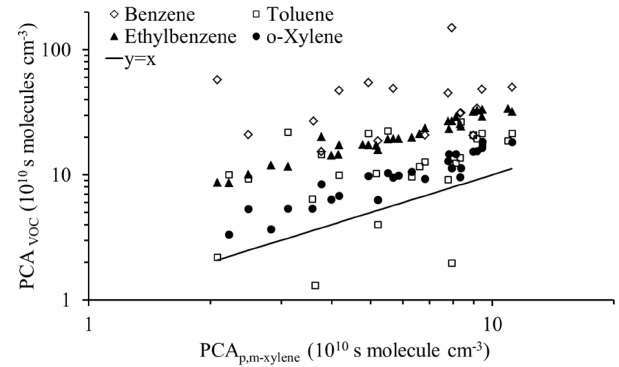
Figure 7. Dependence between the R [OH]d t (PCA) of different VOC and the R [OH]d t (PCA) of p,m -xylene. Only data with R [OH]d t larger than 0 at a 95% confidence limit are shown.